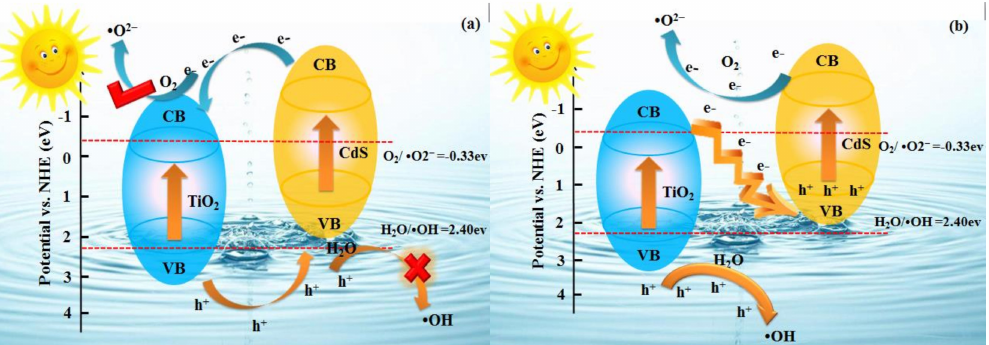
Figure 7. Schematic illustration of proposed photocatalytic mechanism of CdS@TiO 2 composites under visible-light irradiation: traditional heterojunction model ( a ) and Z-scheme heterojunction system ( b